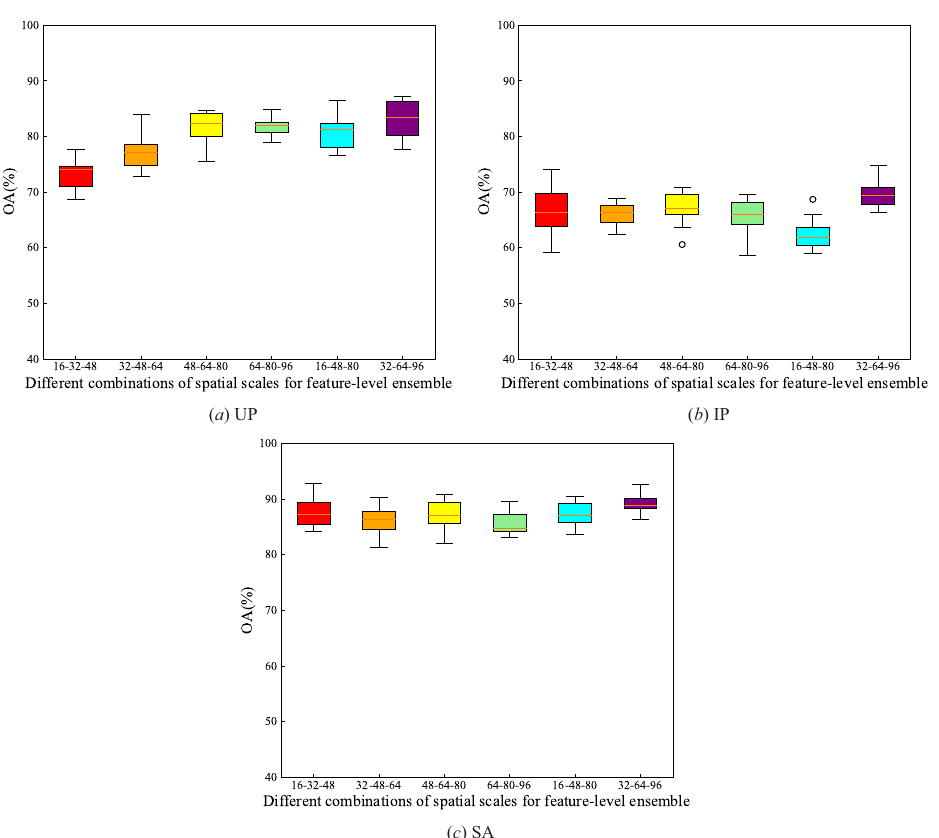
Figure 5. Influence of different spatial scale combinations on classification results.